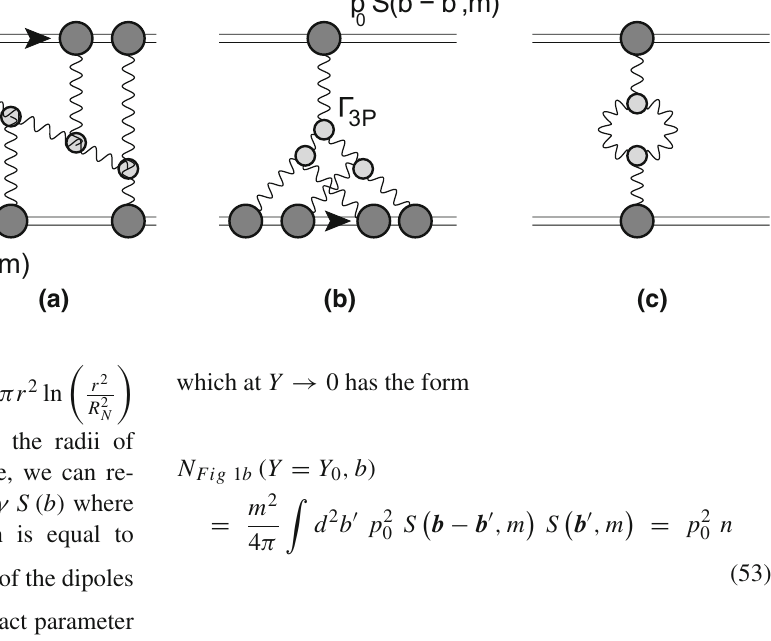
Fig. 1 Examples of the Pomeron diagrams: ’net’ diagrams, which give the main contribution to nucleus–nucleus collisions ( a ); the diagrams of the Balitsky–Kovchegov equation ( b ); and the contribution to the Green function of the Pomeron ( c